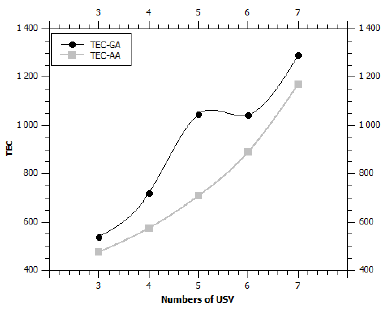
Figure 23: DTotal energy consumption in a zone with a low degrees of